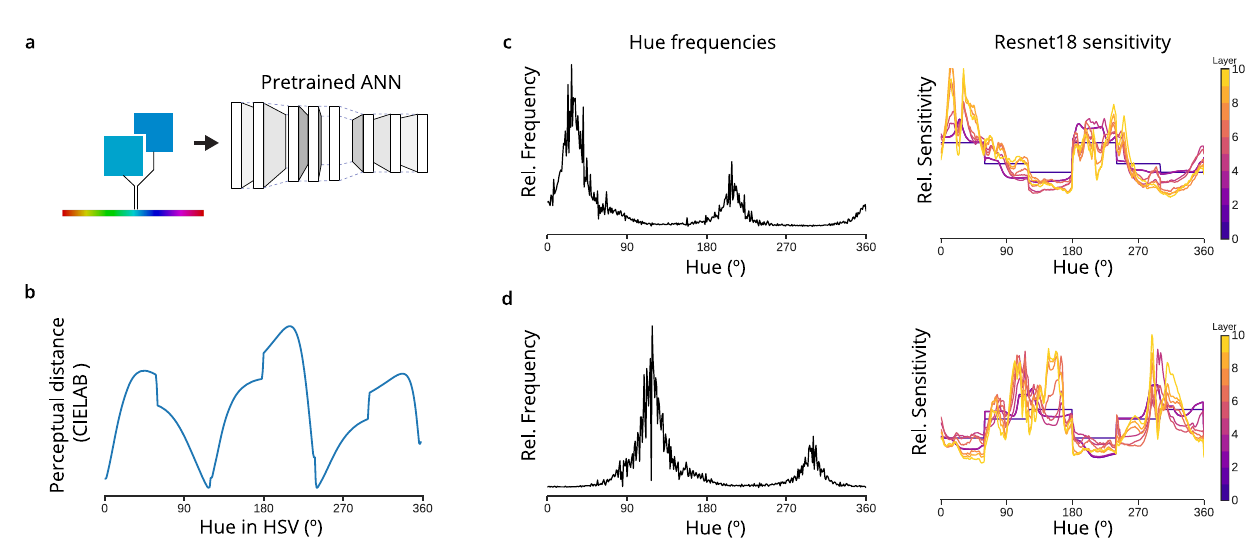
Fig.3|ThesensitivityofANNstohuealsomatchesimagestatistics.a Thecolor ofauniformimageisvaried;inHSVcolorspace,saturationandvalueareheld fi xed andthehueisvaried.Resultsareaveragedoverpossiblesaturationsandvalues. b In humans, the sensitivity to the H axis can be inferred by the perceptual distance between uniformly spaced H values (calculated using the